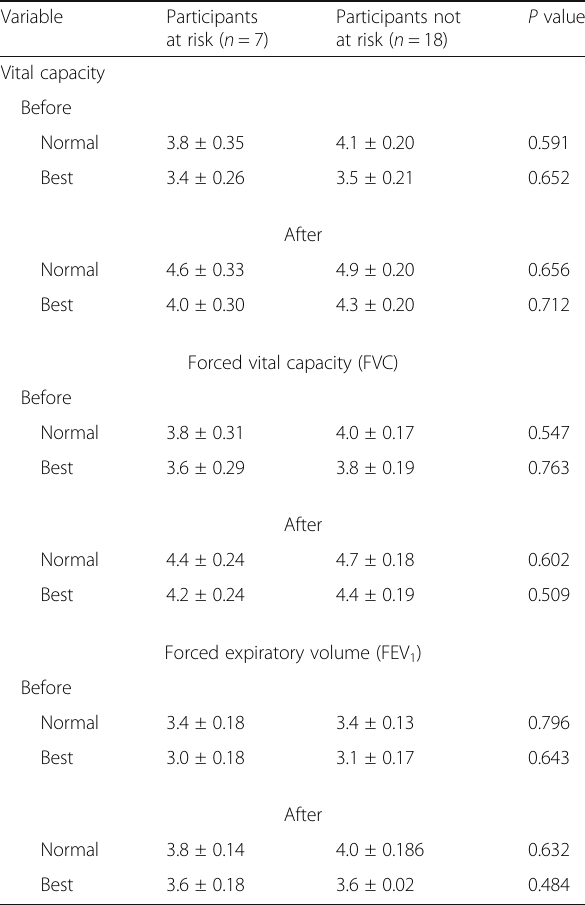
Table 5 Spirometry of participants at diabetic risk and